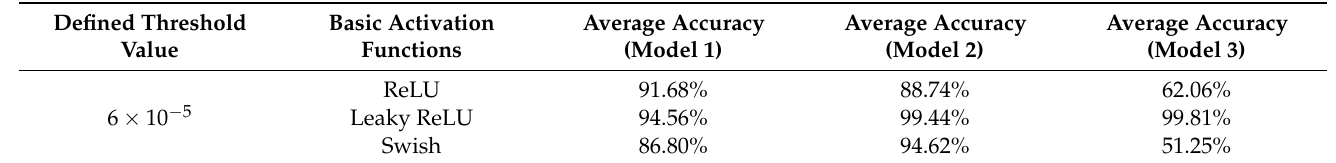
Table 1. Average Accuracy chart of ReLU, Leaky ReLU and Swish functions of DNN, obtained from the addition or removal of internal layers of the same applied DL